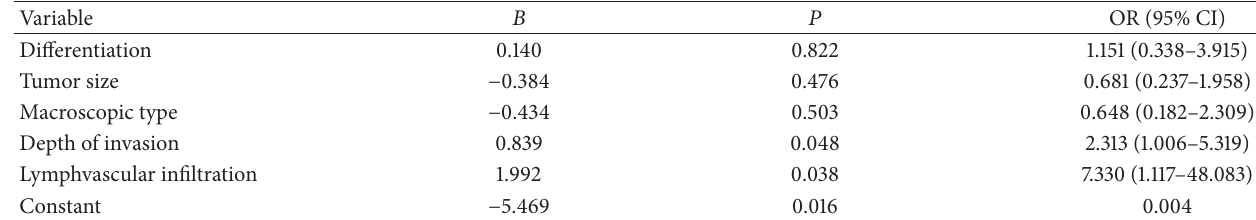
Table 2: Multivariate analysis of risk factors for lymph node metastasis.